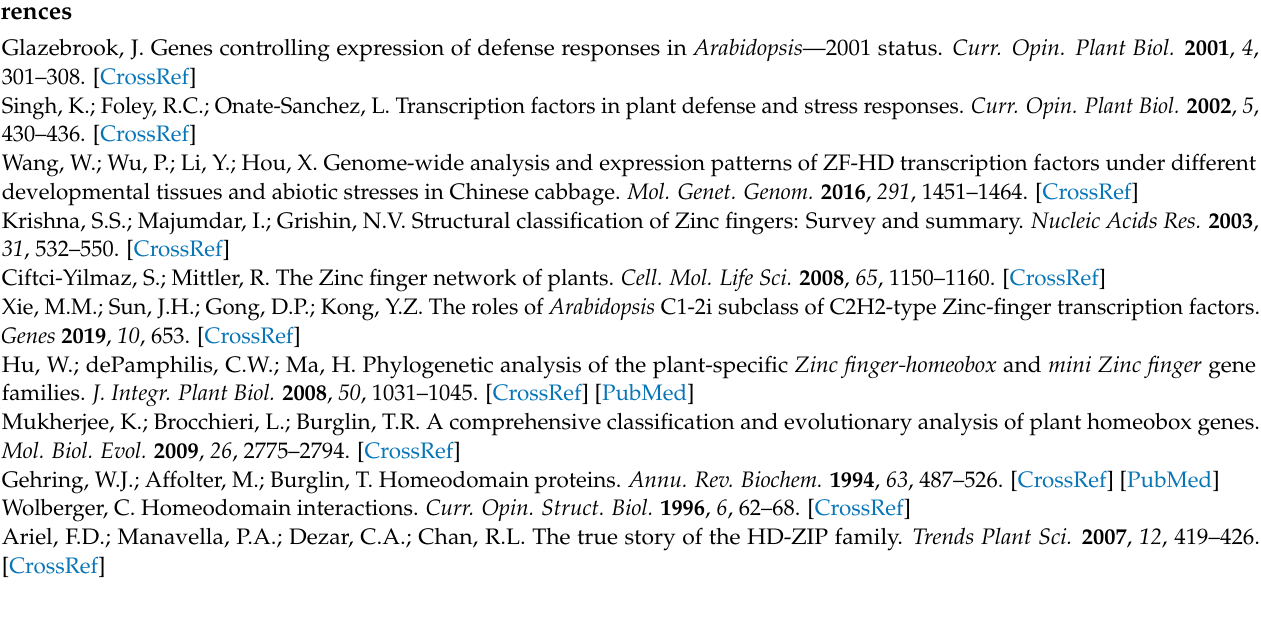
Supplementary Materials: The following are available online at https://www.mdpi.com/2073-439 5/11/3/406/s1, Figure S1. Gene structure and motif organizations of NtZF-HD members in tobacco. Figure S2. The expression pattern of the selected NtZF-HD genes in different tissues. Table S1. The ZF-HD protein sequences of Arabidopsis , tomato, and tobacco, Table S2. The RT-qPCR primers of NtZF-HD genes, Table S3. The detailed information about NtZF-HD genes and NtZF-HD proteins in tobacco, Table S4. The amino acid sequences of motifs, Table S5. The syntenic analysis of NtZF-HD genes, Table S6. The predicted cis-acting elements in the promoter region of NtZF-HD